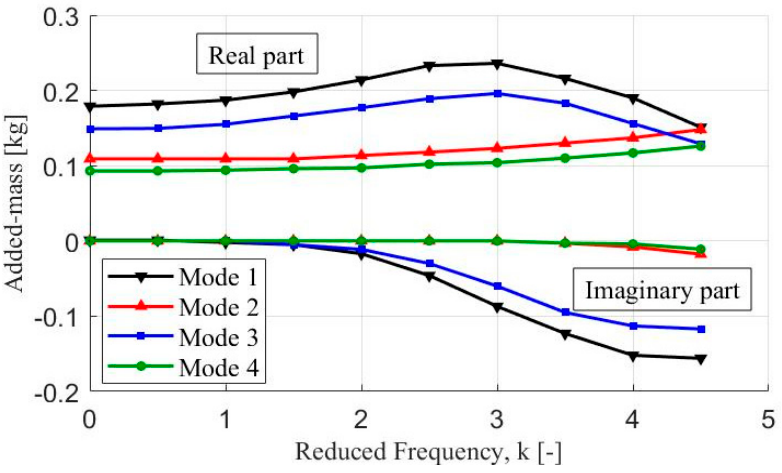
Figure 8. Added mass terms as a function of reduced frequency for the trapezoidal cantilever plate.